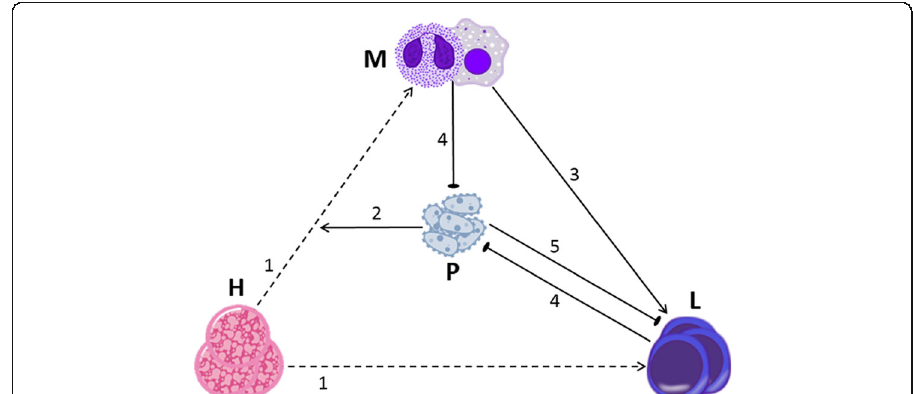
Fig. 3 A graphical display of Model V2. The only change from model V1 (see Fig. 1) is the addition of effect 5, by which persistent pathogen induces lymphocyte exhaustion, via suppression of HLA-DR expression in APCs or through the PD-1/PD-L1 pathway. Effectively, exhaustion in the model manifests itself as an increased mortality rate of lymphocytes. See Additional file 1 for the equations and parameters of model V2. Regular arrows indicate activation; blunted arrows indicate inhibition; dashed arrows indicated